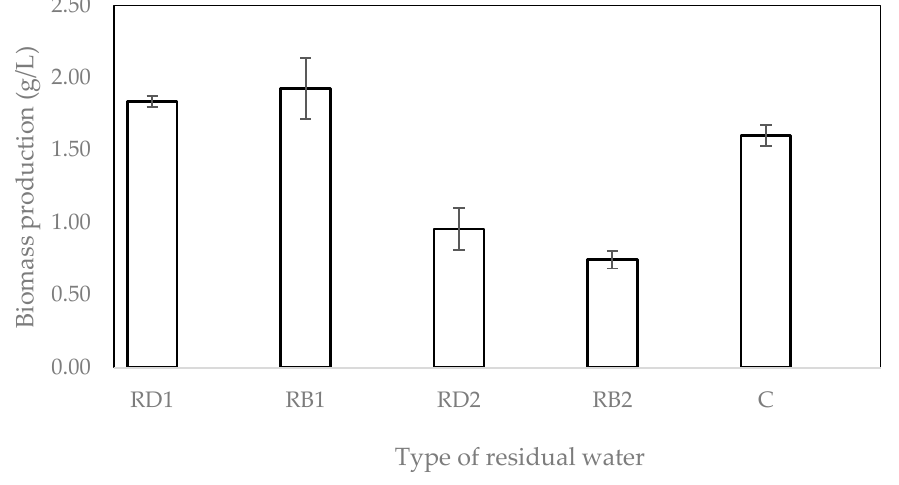
Figure 1. Biomass of R. oligosporus in different types of residual waters from tempeh processing